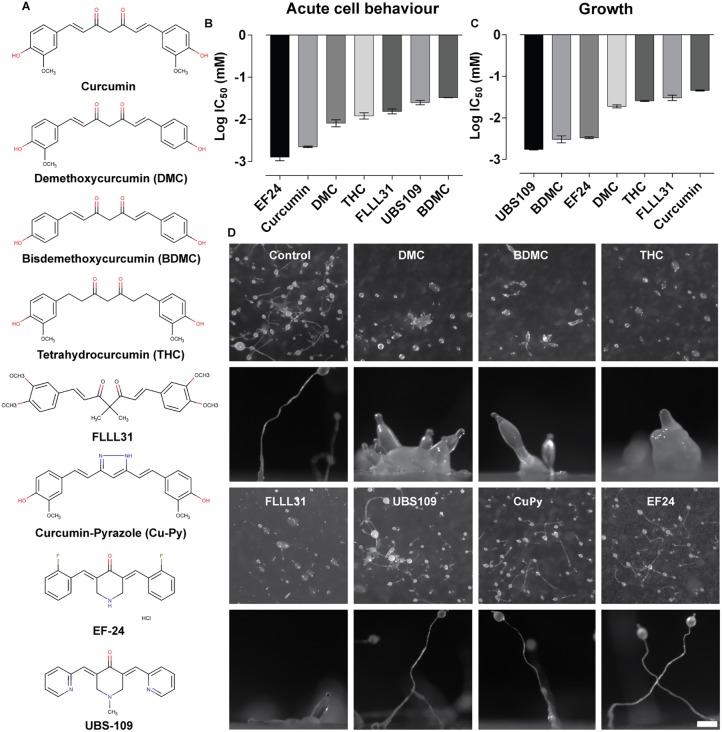
Quantification of the acute cell behaviour, growth and developmental effects of curcumin derivatives on D. discoideum. (A) Structure of natural and artificial derivatives used in a quantitative structural analysis of curcumin effects in D. discoideum. (B) Concentration-dependent responses were determined for cell behaviour (protrusion formation) and illustrated as the IC50 for each compound with errors shown as 95% CIs (Figs. S1 and S2). (C) Concentration-dependent responses were determined for cell growth and illustrated as the IC50 for each compound with errors shown as 95% CIs (Figs. 3 and 4). Data from B and C are presented as mean±s.e.m. of triplicate experiments. (D) Cells were developed on agar over 22 h in the absence of compounds (vehicle only), or the presence of curcumin derivatives at concentrations shown to block growth (100 µM FLLL31, 25 µM DMC, 20 µM BDMC, 100 µM THC, 6 µM EF24, 5 µM UBS109 and 100 µM CuPy). All images are representative of triplicate experiments. Scale bar: 0.25 mm for all side view images.